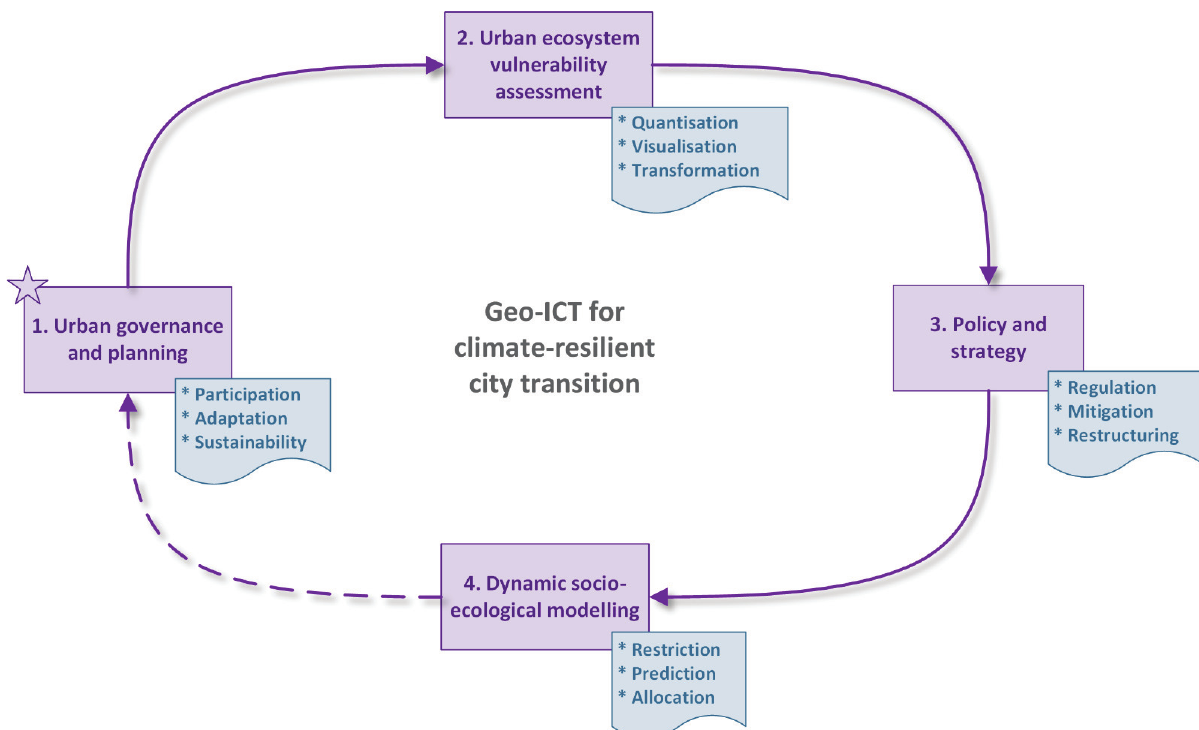
Figure 1. Conceptual framework of Geo‐ICT for climate‐resilient city transition. of urban ecosystem vulnerability assessment to quan‐ tify and visualise the status quo of existing